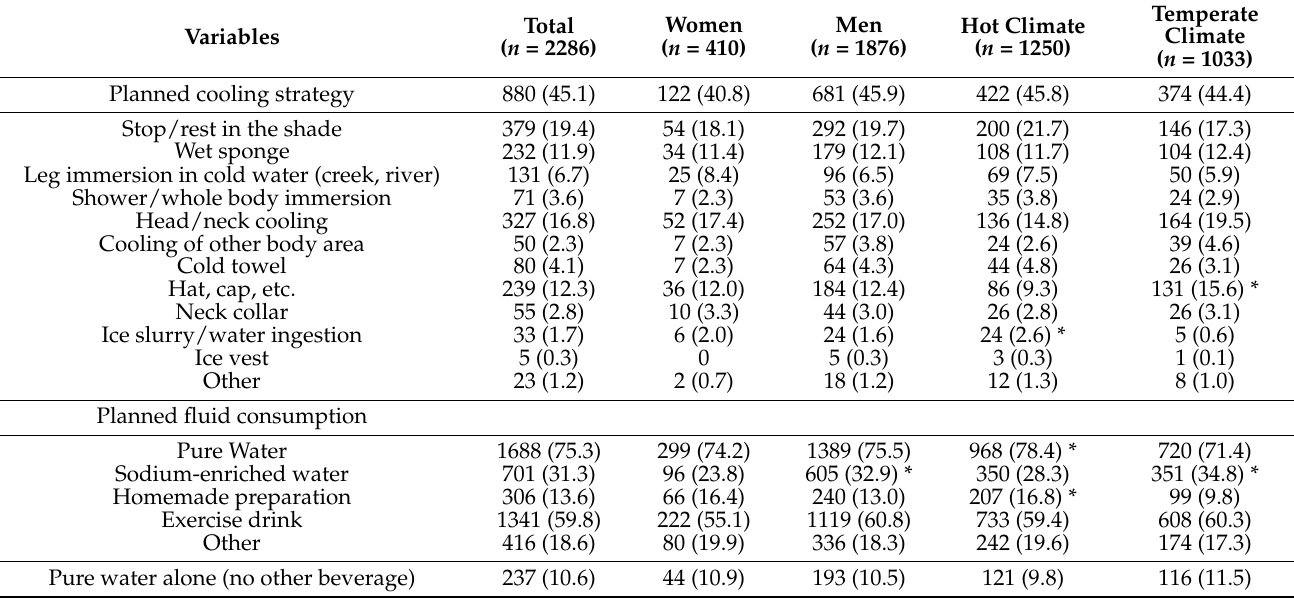
Table 3. Planned hydration and per-cooling strategies in the Grand Raid de la R é union runners by total sample and according to sex and climate of